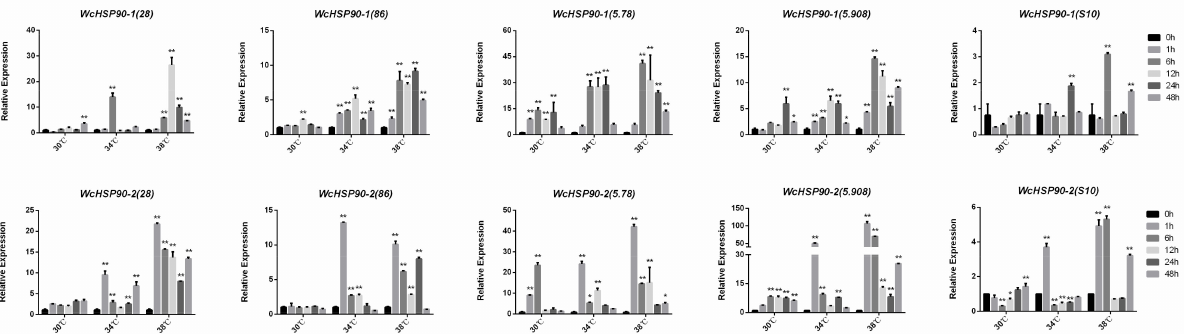
Figure 5. Analysis of expression patterns of WcHSP-90 gene under different temperature treatments. The different strains ‘28’, ‘86’, ‘5.78’, ‘5.908’, and ‘S10’ of W. cocos are shown. All data are means ±